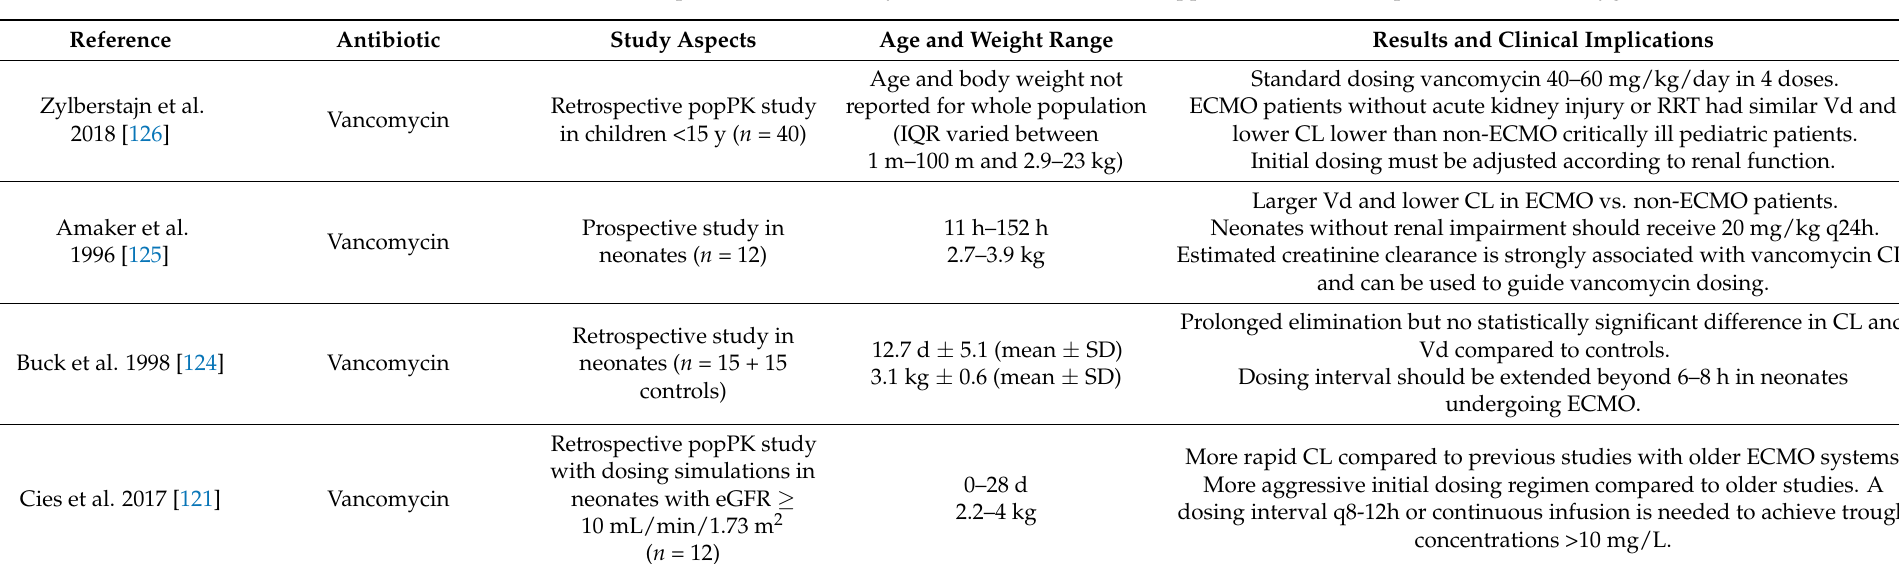
Table 5. Overview of all antibiotic PK studies performed in critically ill children and neonates supported with extracorporeal membrane